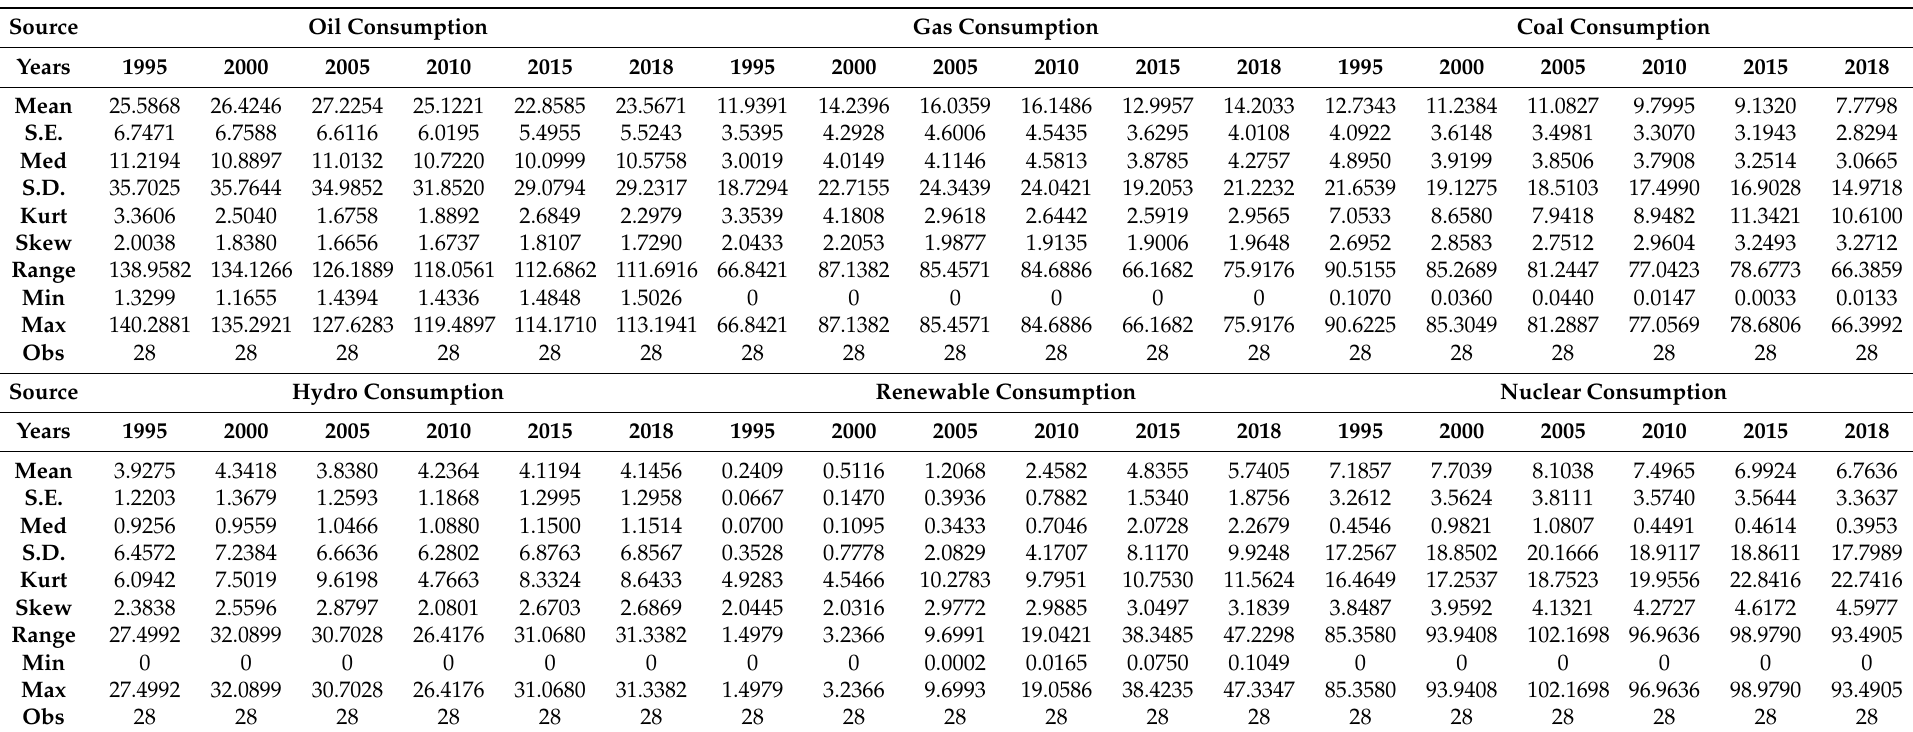
Table A2. Descriptive statistics for energy consumption according to different sources in European